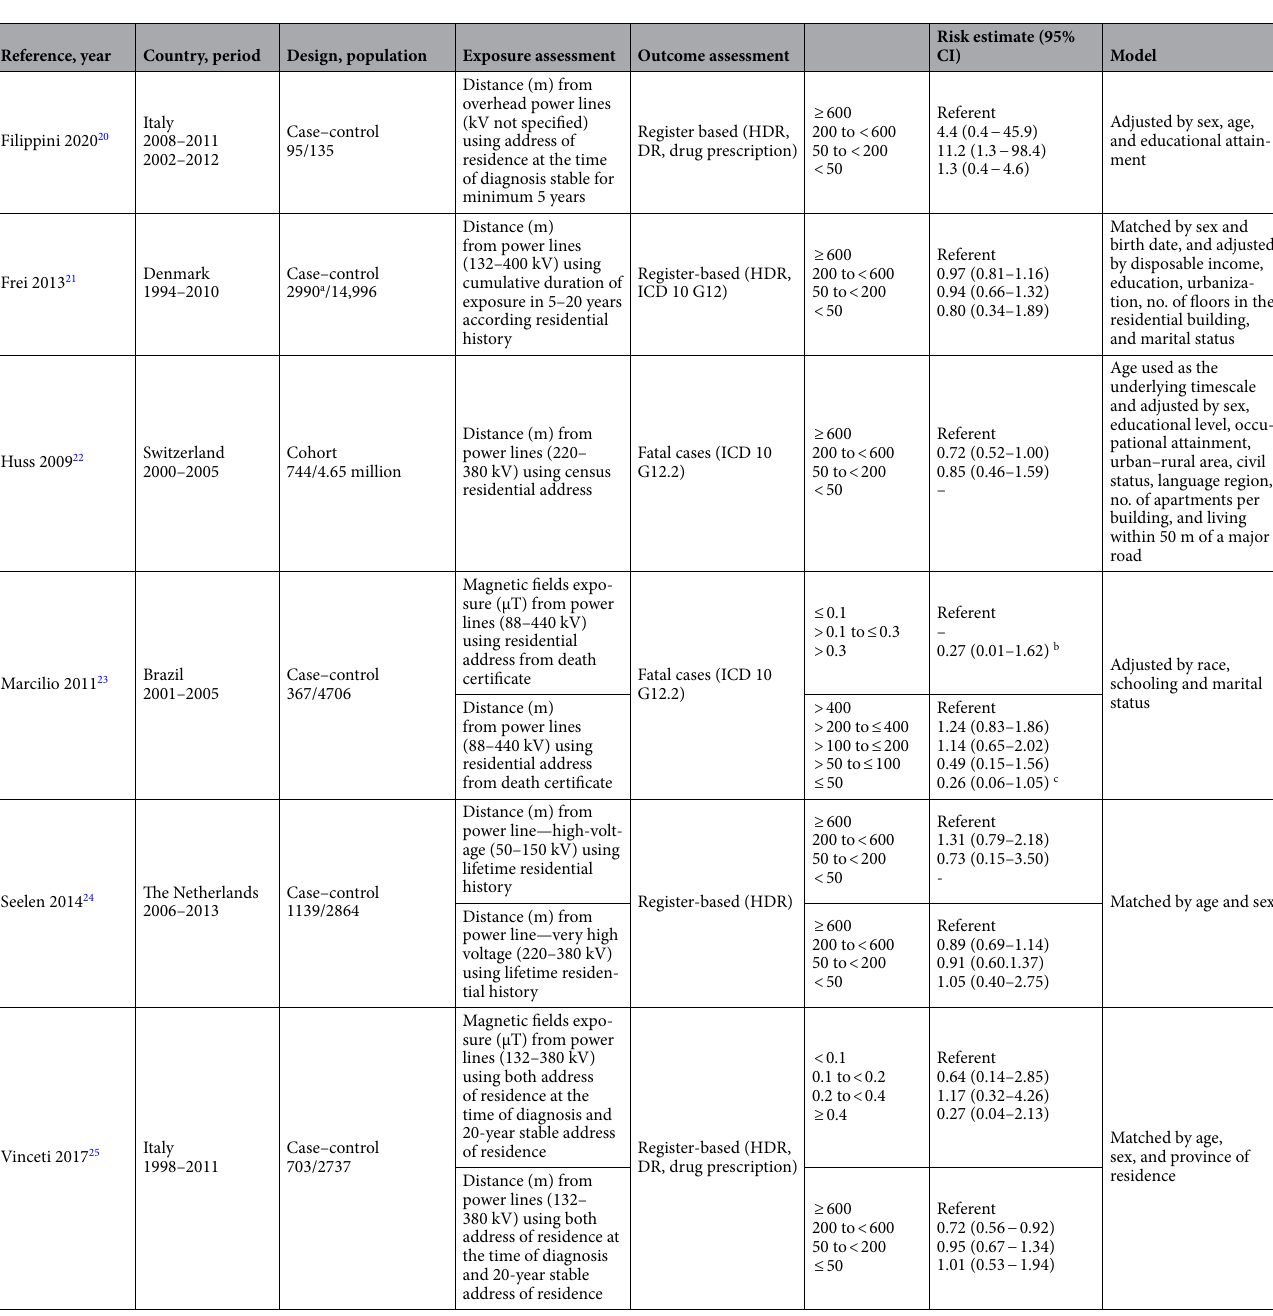
Table 1. Characteristics of includes studies. DR disease registry, HDR hospital discharge registry, HR hazard ratio, ICD International Classification of Diseases, OR odds ratio. a Motor neuron disease. b Computed from corresponding figure from adjusted model not